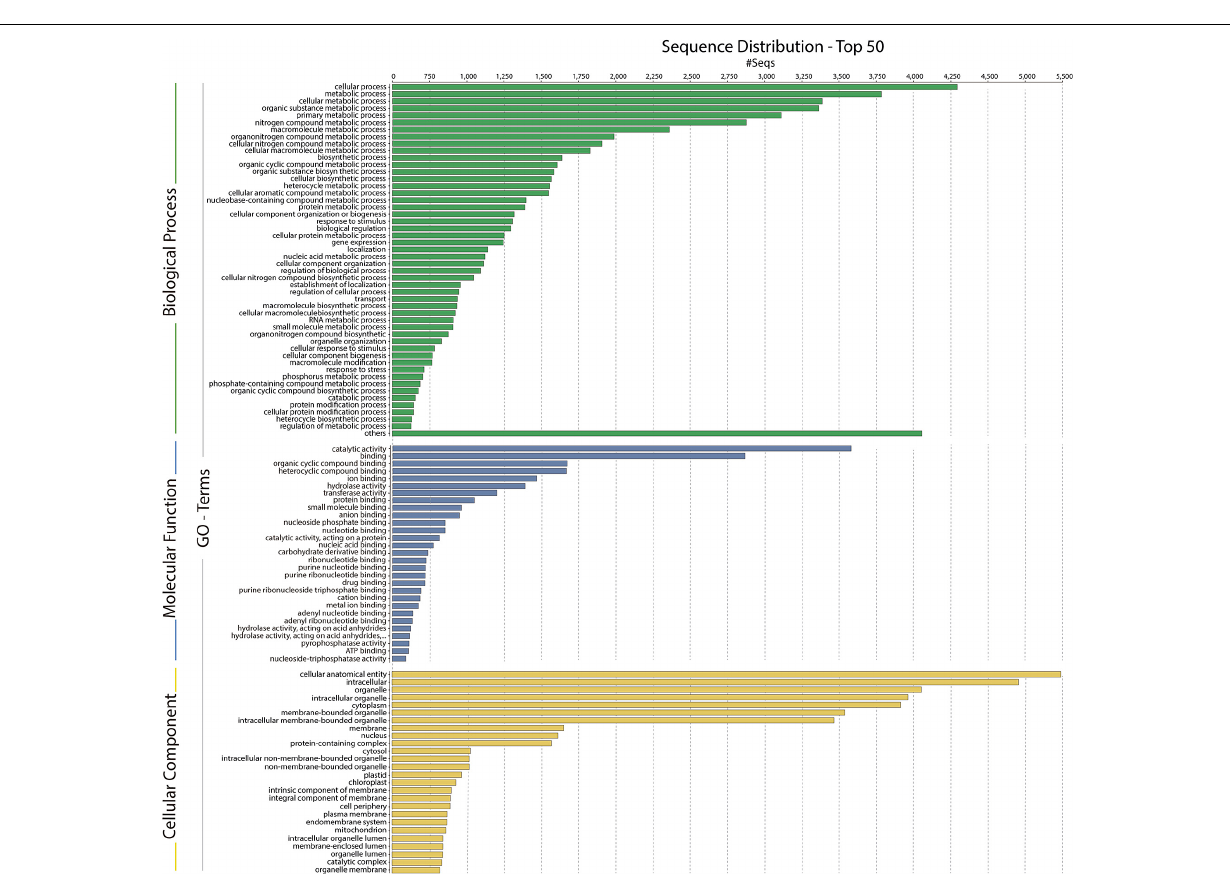
Frontiers in Plant Science |